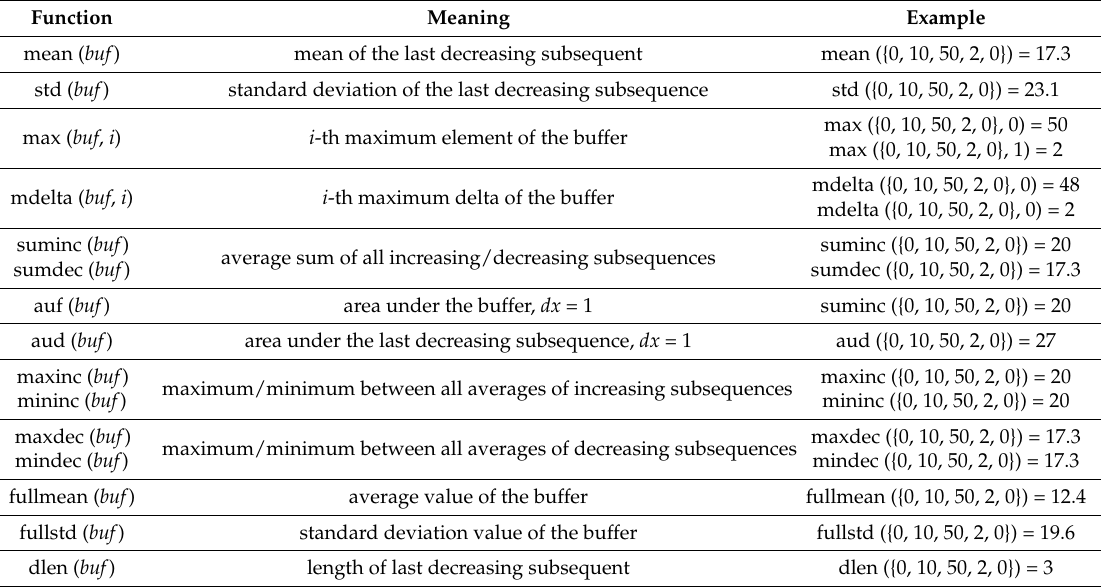
Table 5. Atomic functions that are invariant to the length of the time